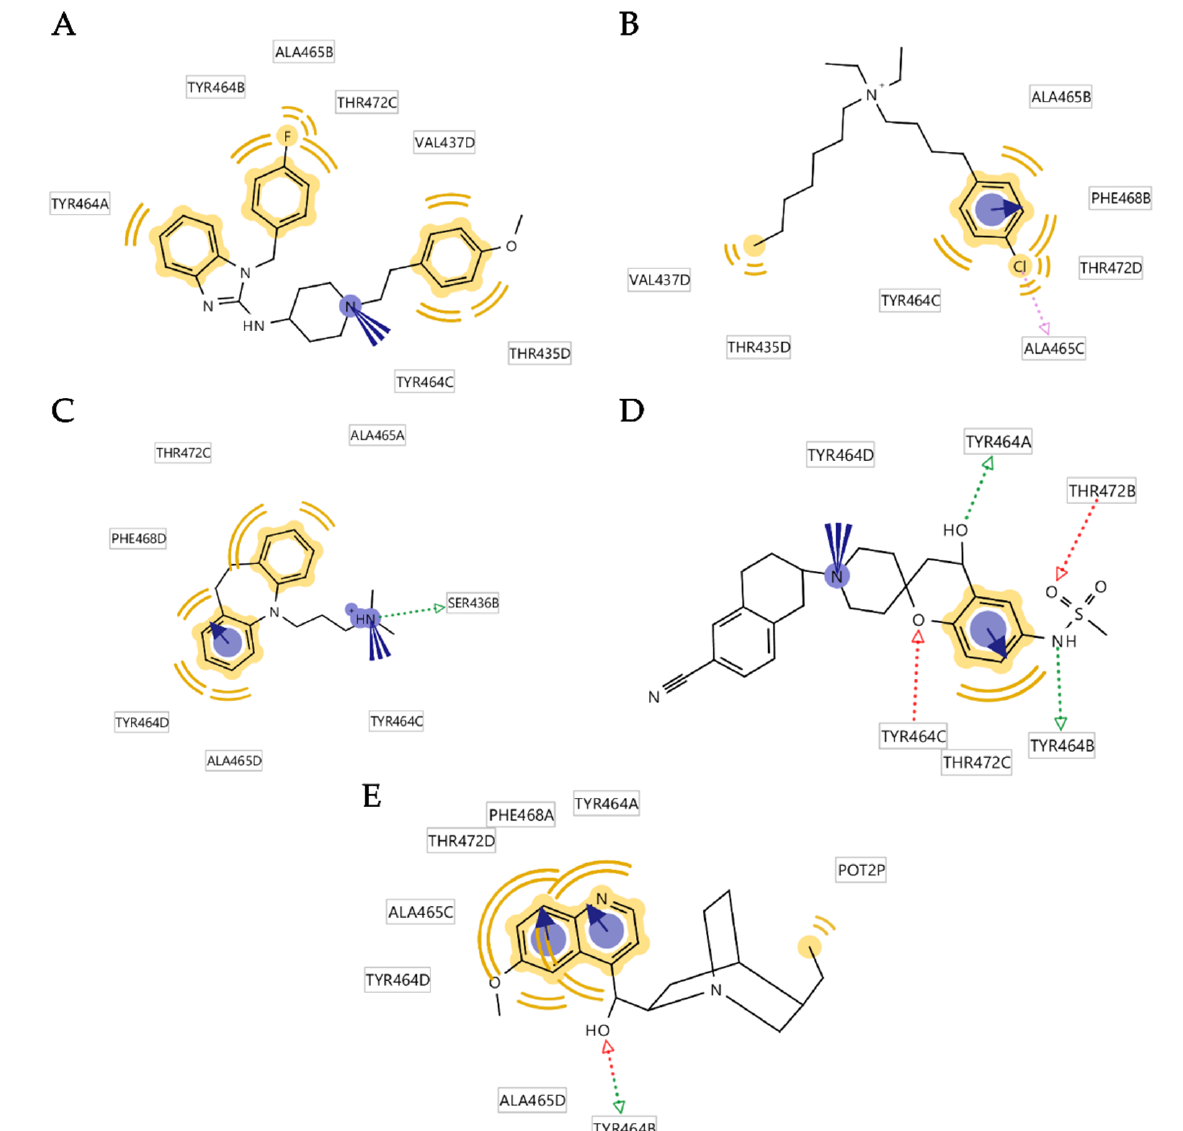
Figure 11. Two-dimensional projections of the frequently appearing pharmacophore models for astemizole ( A ), clofilium ( B ), imipramine ( C ), MK-499 ( D ), and quinidine ( E ) in complex with the homology model of the K V 10.1; these were used in the creation of the final merged pharmacophore model. The pharmacophore features are: hydrophobic features, yellow; aromatic features, blue discs with arrows; hydrogen bond donors, green arrows; hydrogen bond acceptors, red arrows; positive ionizables, blue circles.